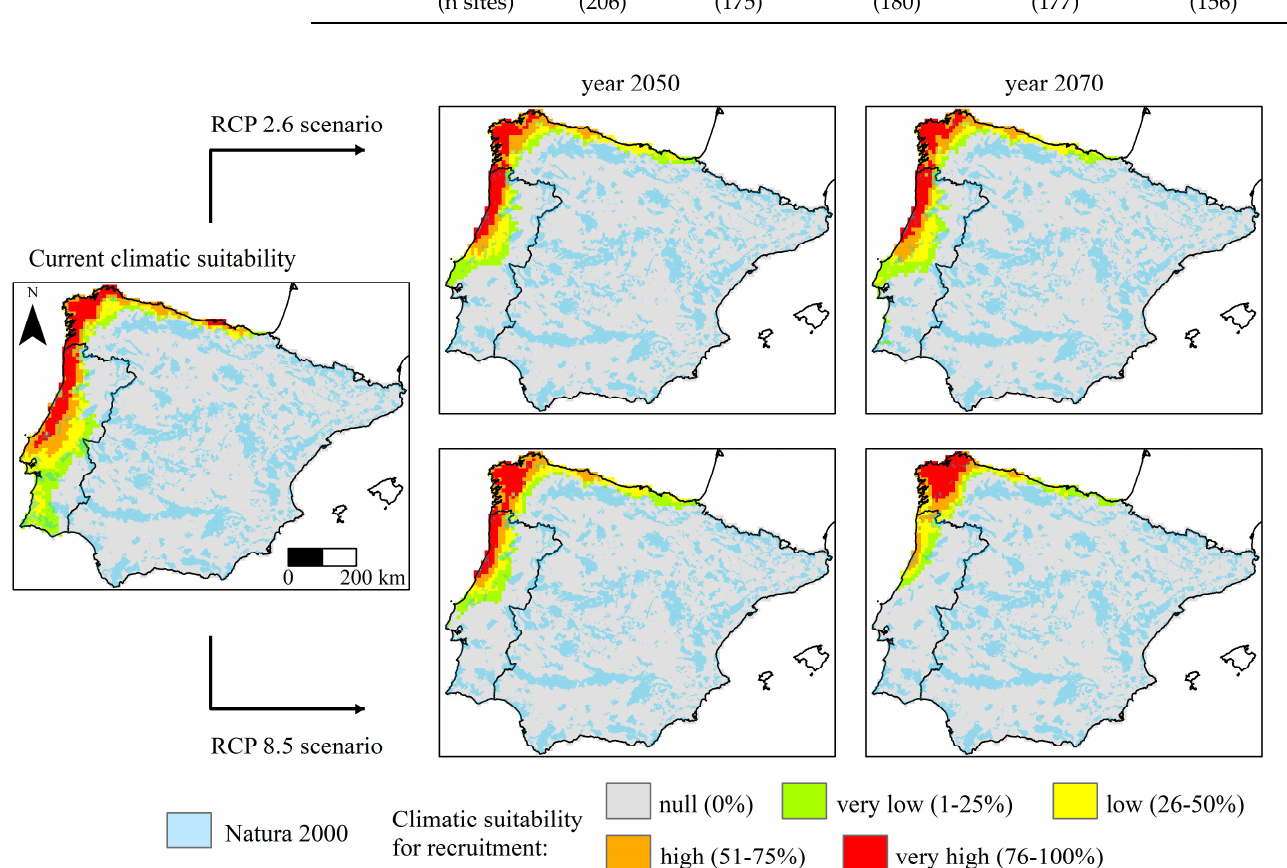
Figure 2. Current and future climatic suitability (%) for Eucalyptus globulus recruitment in Iberia in the years 2050 and 2070 under climate change scenarios RCP2.6 and RCP8.5. Climatic suitability corresponds to the probability (%) of finding